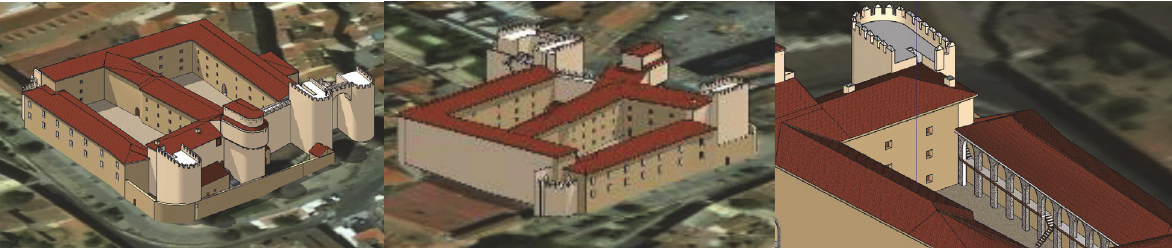
Figure 3. Intramural buildings: different views of the Alcázar after 1750.